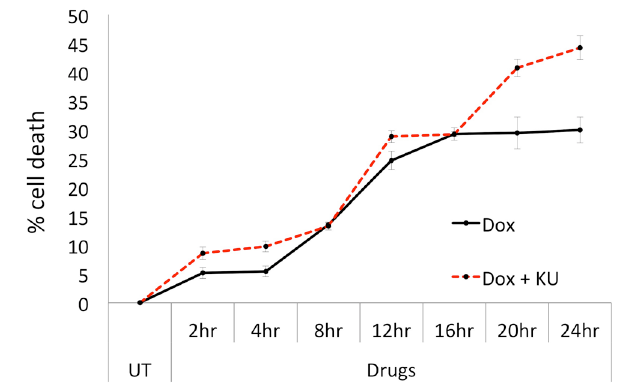
Figure 7. Inhibition of ATM kinase by small molecule inhibitor sensitises cells to time dependent 100nM Dox treatment. HaCat cells were seeded at a density of 2.5 x 10 3 cells in quadruplicates in 96- well plates and allowed to attach for 24 h. Following this, cells were either left untreated, treated with 100nM Dox or with a combination of 100nM Dox and 10μM KU for the indicated time points and processed for Neutral Red uptake based cytotoxicity assay as described in materials and methods. Readings were taken in 96-well multi plate reader (Modulus template®) by measuring absorbance at 540nm. Values are means of the absorbance acquired from quadruplicate treatments and normalised to the mean value of untreated control (UT) and expressed as % cell death with the formula 100-[(Abs 540 treated sample/Abs untreated sample) x 100]. Data is based on n=3 540 independent